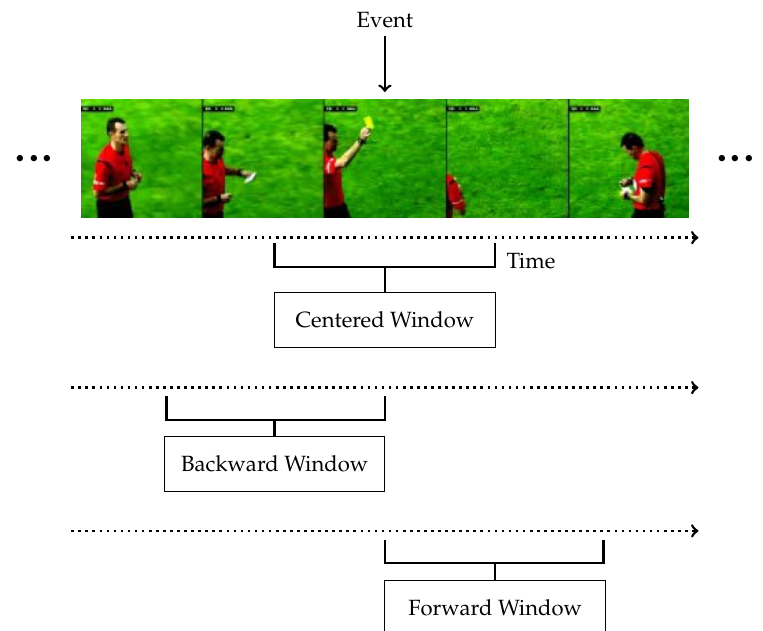
Figure 9. Illustration of window positions relative to the event, for a given sample. A centered window uses both past and future information, while a backward or forward (shifted) window relies only on the past and future, respectively.